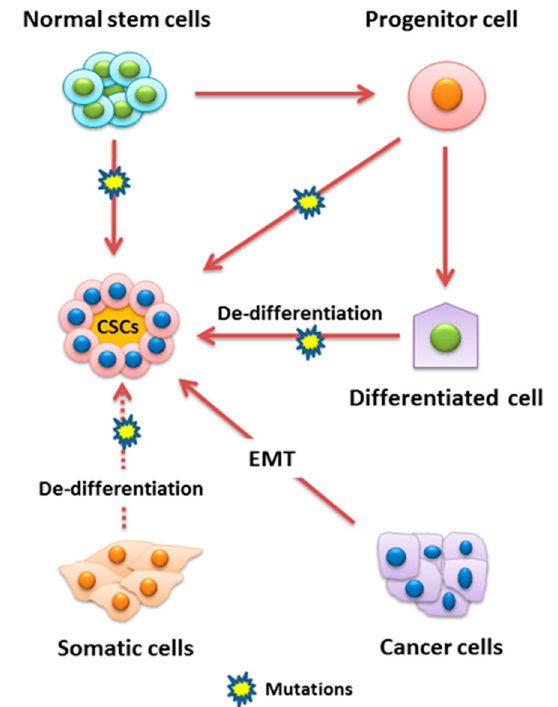
Figure 1. An overview of the origin of cancer stem cells (CSCs): CSCs can originate and develop from several cells. Normal stem cells may become CSCs through mutations, or it can develop into progenitor cells which in turn can develop into CSCs via mutations. In addition, progenitor cells can grow into CSCs through mutations and become a differentiated cell, which in turn can becomes undifferentiated and grow into CSCs. Moreover, CSCs can develop from dedifferentiated somatic cells or from cancer cells that undergo epithelial to mesenchymal transition (EMT).